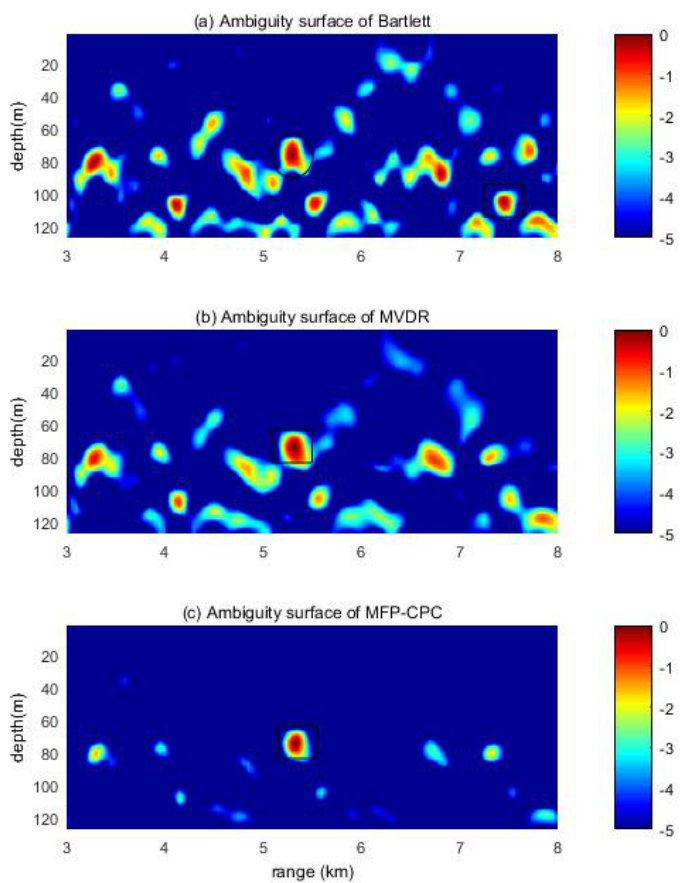
Figure 7. Ambiguity surfaces of the moored source at the first minute.